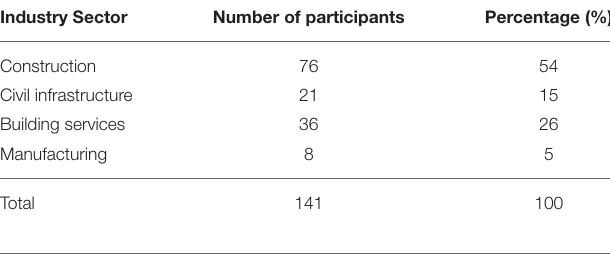
TABLE 3 | Sample demography (sector).